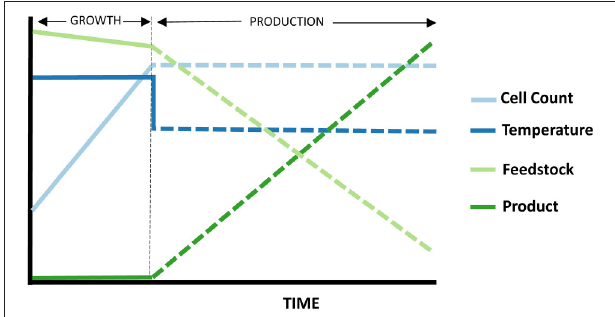
FIGURE 3 | Temperature-shift strategy involving a hyperthermophilic host expressing more moderately thermostable recombinant enzymes. Reduced temperatures result in a transition from growth to production phase. The hosts enzymes, naturally optimized for higher temperatures, become less active, and the cell growth rate stalls. Meanwhile, the recombinant enzymes from less thermophilic sources then re-fold and begin producing chemicals. Enzyme production can furthermore be coupled to temperature shift through the use of cold-induced